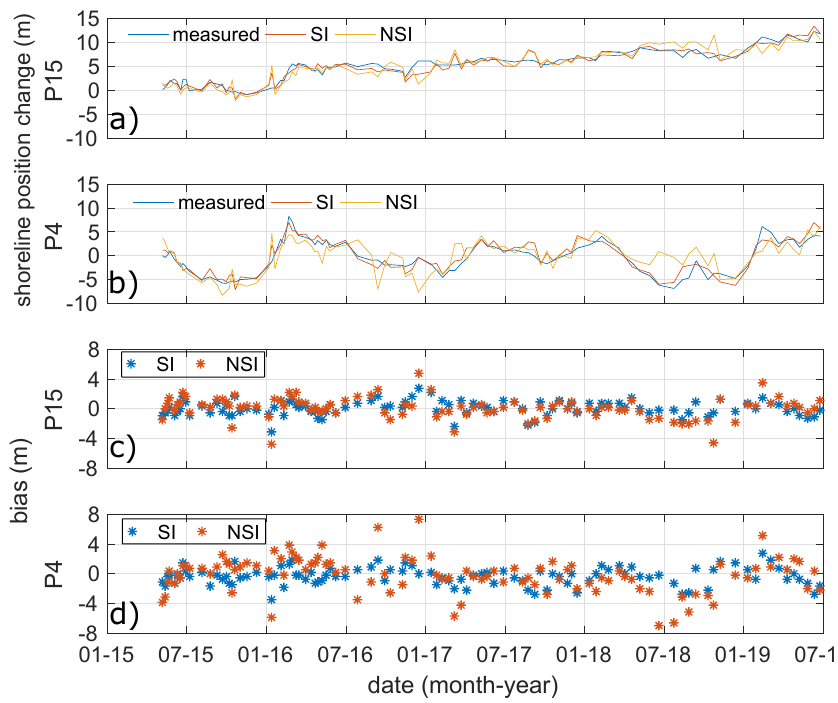
Figure 8. Shoreline position change in time at P15 ( a ) and P4 ( b ). Bias in image-derived shoreline position from in situ measurements at P15 ( c ) and P4 ( d ).